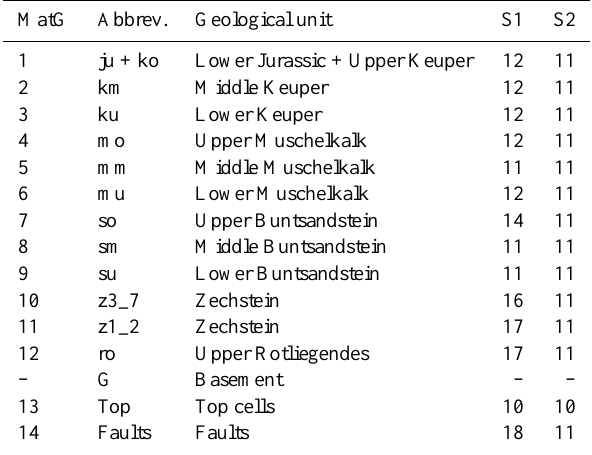
Table 1. Isotropic permeability values pκ groups (MatG), i.e., layers and faults, with κ (m 2 ). MatG